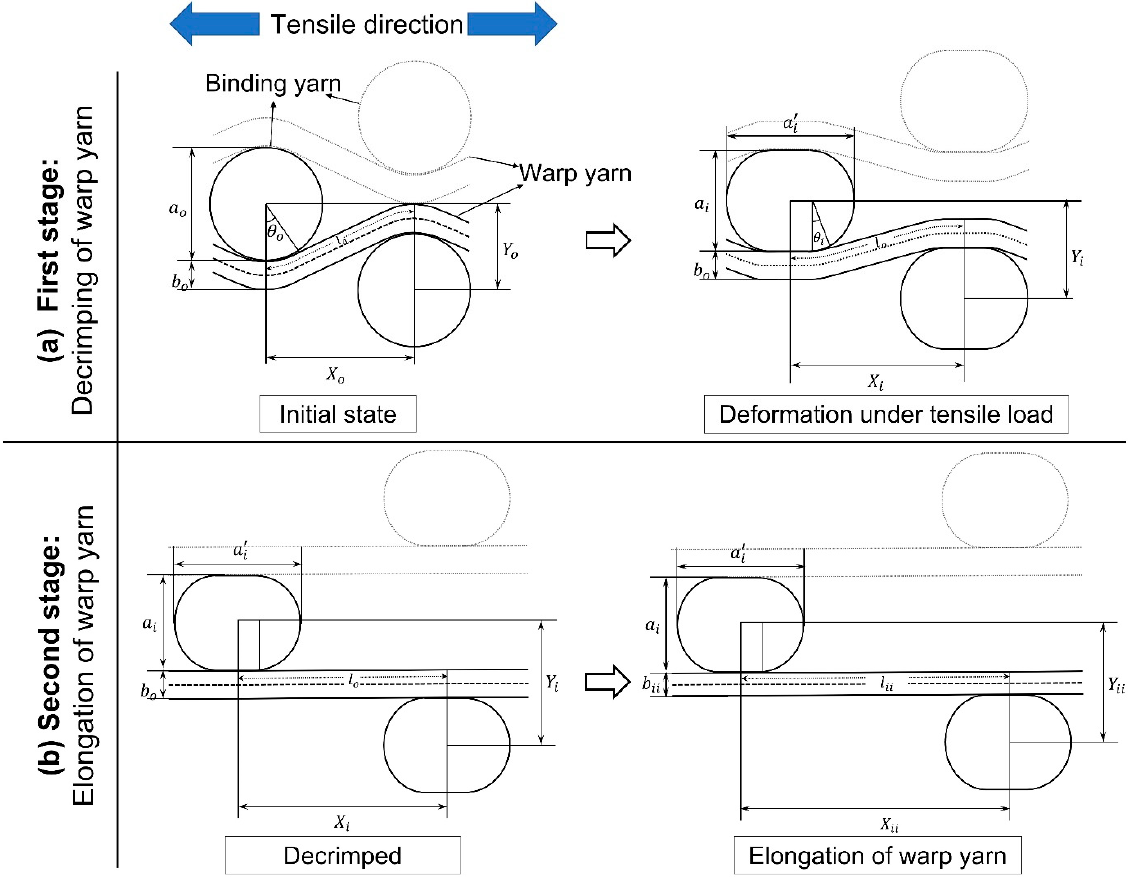
Figure 5. Geometrical model of 3D auxetic structure: ( a ) decrimping of warp yarns under tensile load; ( b ) elongation of warp yarns under tensile load.